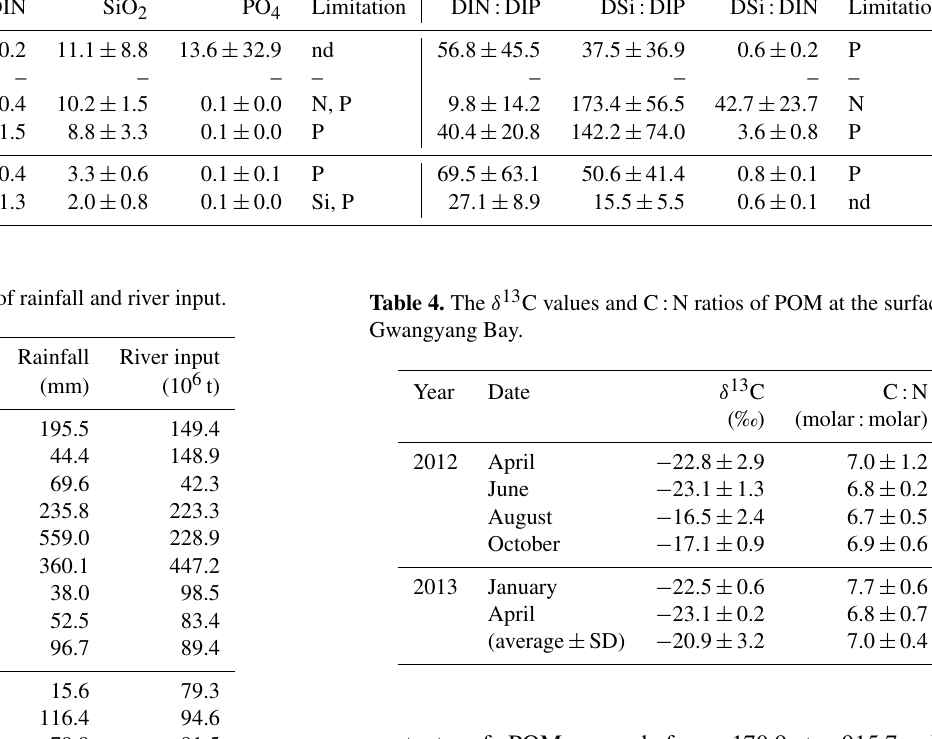
Table 2. The observed nutrient limitations during the study period (nd: not detected). Based on absolute concentrations (µM) Based on molar ratios